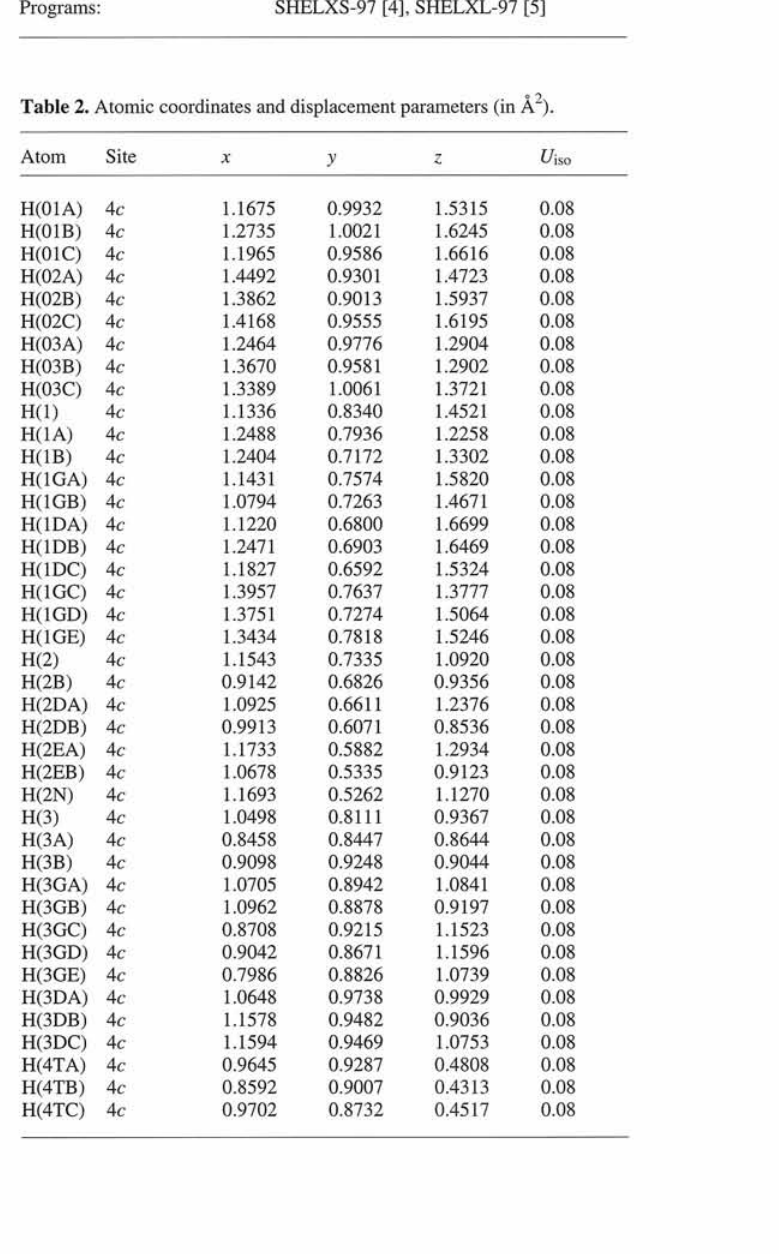
Table 1. Data collection and handling.